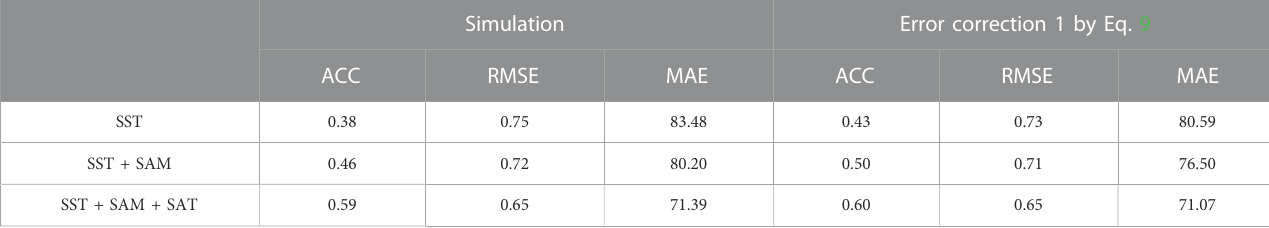
TABLE 3 Evaluations of simulated and corrected Weddell Sea SIC anomaly in the whole fi tting period (1979 – 2012). Simulation Error correction 1 by Eq.